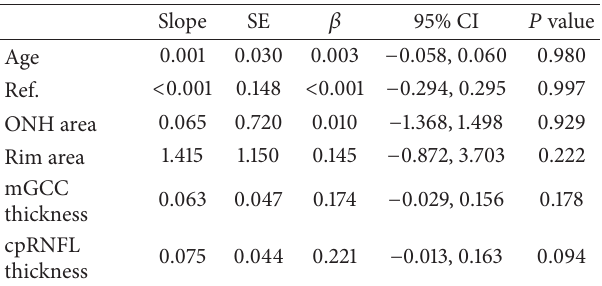
Table 5: Multiple regression analysis for the relationship between MD and other